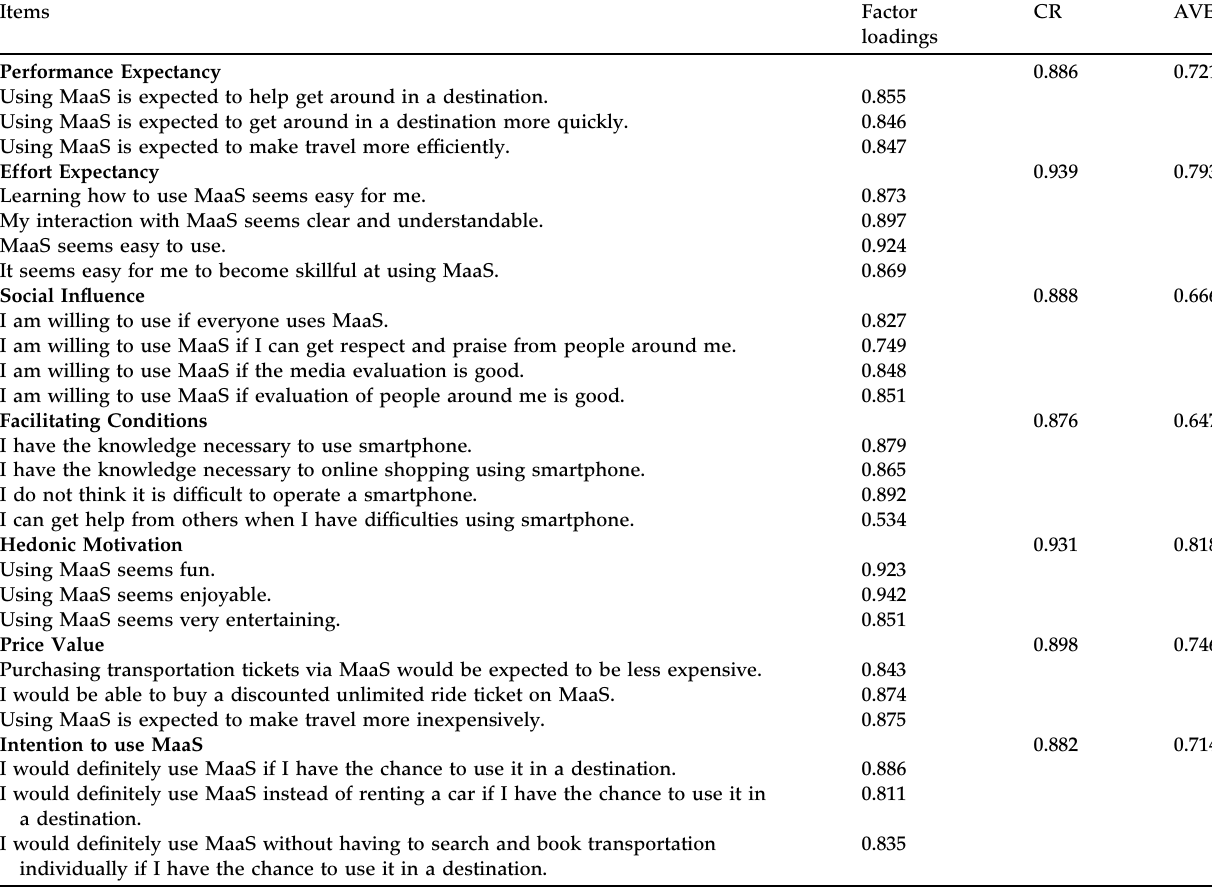
Table 1. Factor loadings, CR, and AVE of the measurement